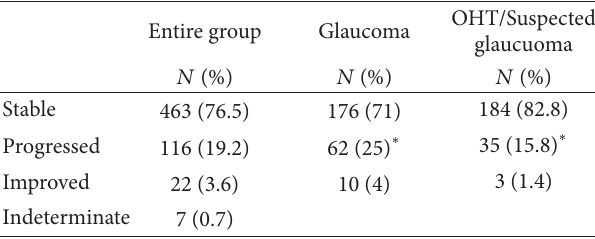
T 5: �ates of progression/stability when previous �elds